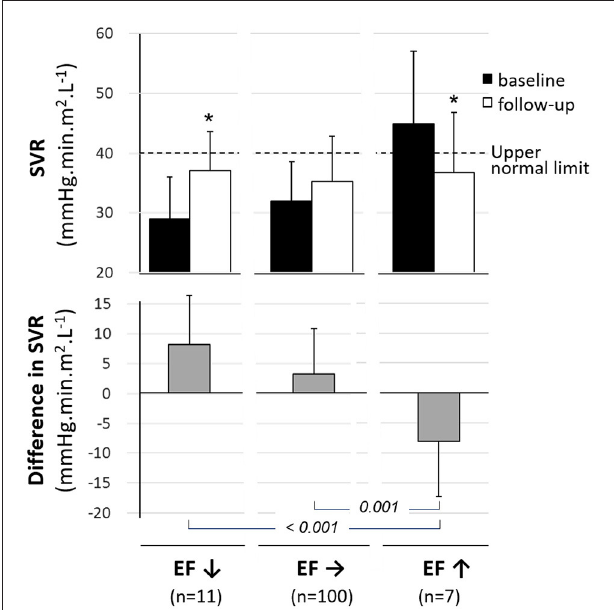
FIGURE 2 | Mean values ( ± SD) for baseline (black columns) and follow-up (white columns) levels of systemic vascular resistance (SVR, upper panel) and for the mean difference in SVR between baseline and follow-up (gray columns, median panel) in subjects categorized in 3 groups based on baseline-to-follow-up variations in LV ejection fraction -i.e., significant decrease (EF ↓ ), significant increase (EF ↑ ) and stable EF (EF → ). * p < 0.05 for paired comparisons between baseline and 6